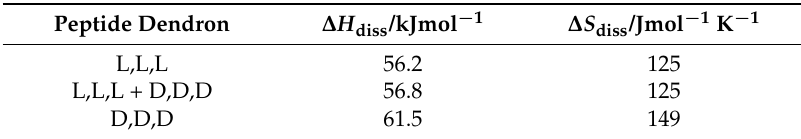
Table 5. Thermodynamic data derived from van ’t Hoff plots with C8R and peptide dendrons as determined by NMR